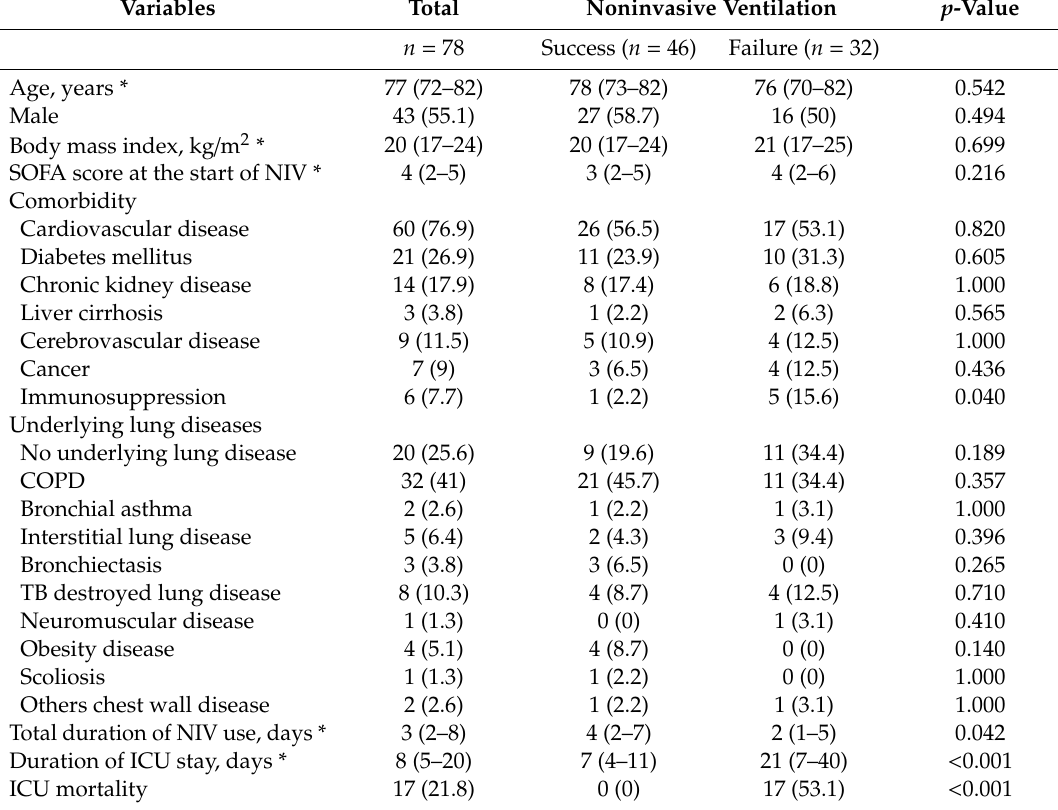
Table 1. Clinical characteristics of patients in this